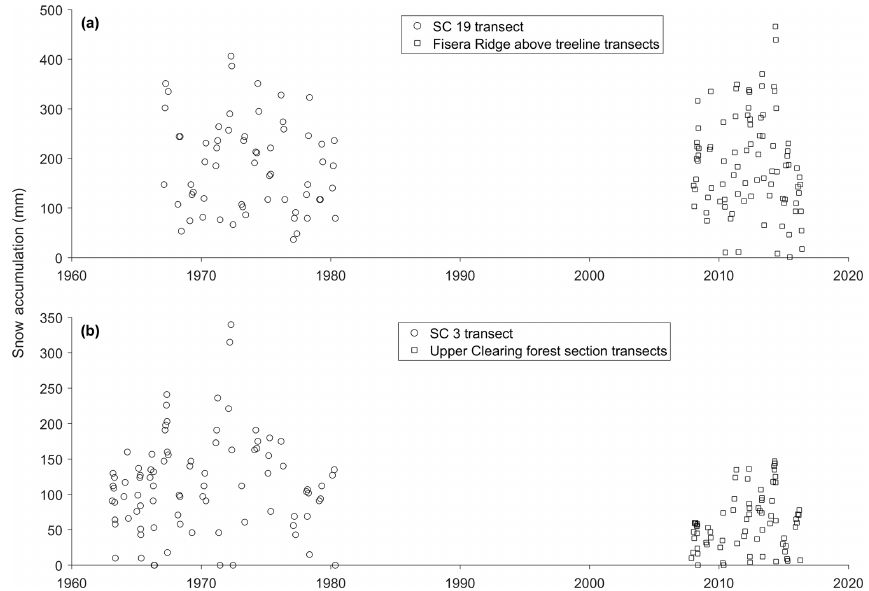
Figure 10. Example of mean transect snow accumulation (SWE) from (a) alpine and (b) montane forest snow survey transects. The historical SWE for alpine and montane forest is from SC 19 and SC 3 transects, respectively. The recent SWE for alpine and montane forest is from Fisera Ridge above treeline transects and Upper Clearing forest section transects,